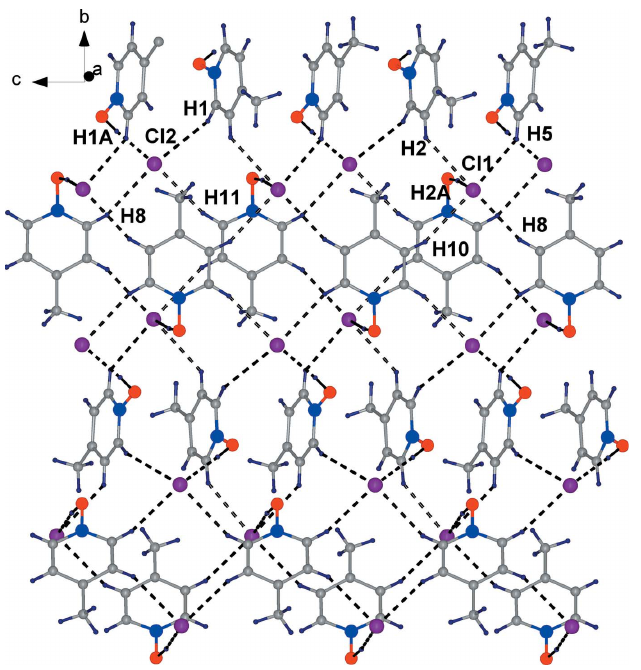
Figure 2 Two-dimensional packing diagram of 1 .